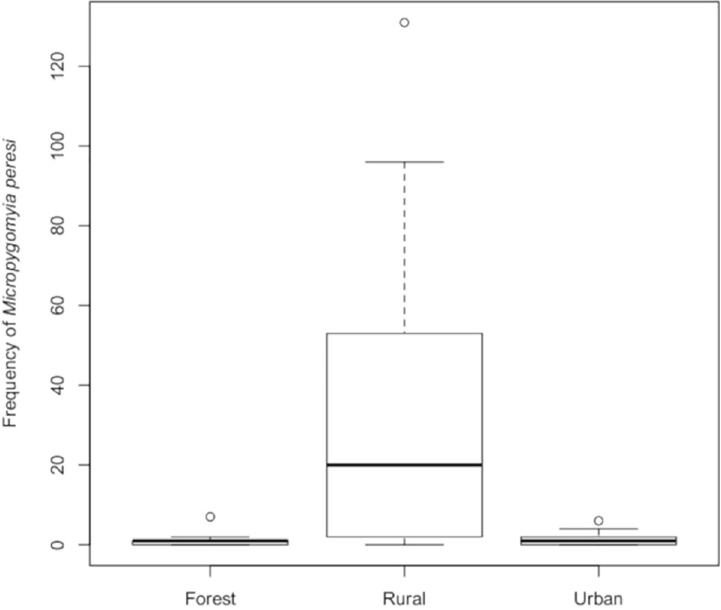
Fig 4. Absolute frequency of Micropygomyia peresi in three areas (forested, rural, urban). Corumba´, Mato Grosso do Sul, Brazil. May 2015 to April 2017.